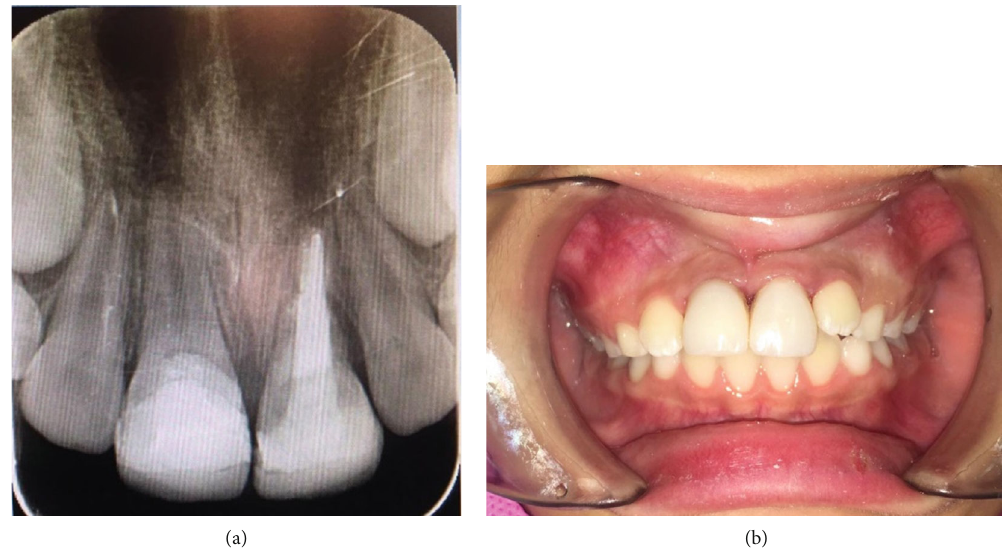
Figure 7: (a) MTA apical plug of 4-5 mm thickness and fi nal obturation. (b) Final restoration of the tooth.